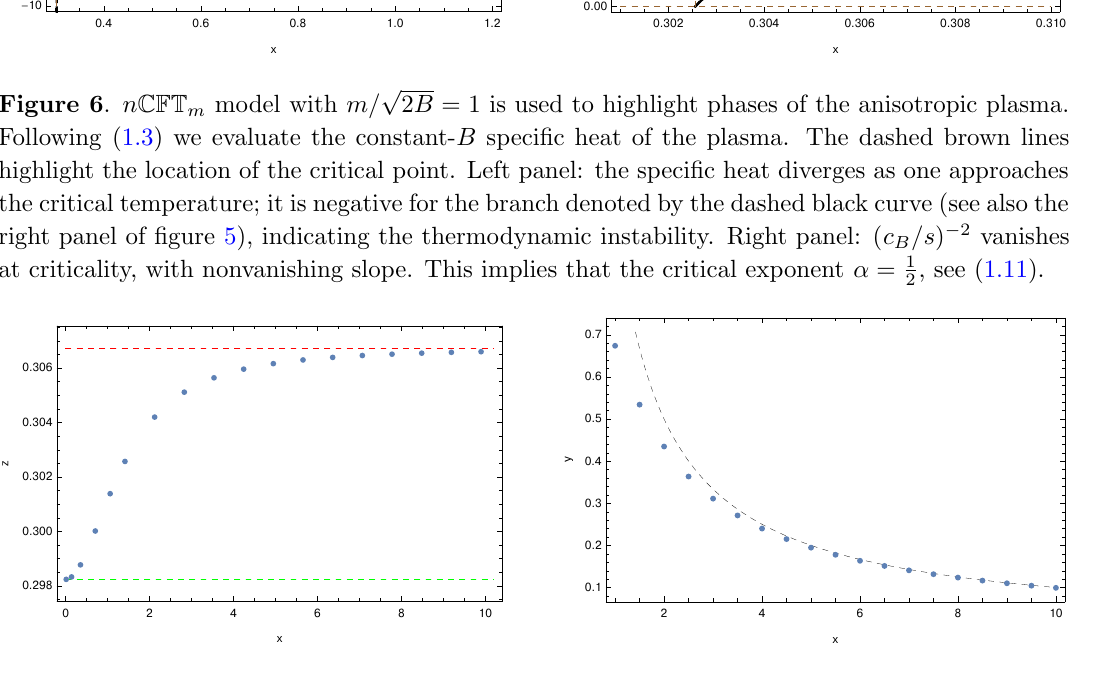
Figure 7 . n CFT m models as well as the conformal models CFT PW ;m =0 and CFT PW ;m = 1 have terminal critical temperature, separating thermodynamically stable and unstable phases. In the p p left panel we present T crit = B as function of m= 2 B ; in the right panel we present the relative entropy at criticality (cid:13) = s crit =s UV (1.13). The dots represent results for the n CFT m models; the dashed horizontal lines (left panel) represent the critical temperature for the CFT PW ;m =0 model (green) and the CFT PW ;m = 1 model (red). The dashed black curve (right panel) represents the p asymptote of (cid:13) as m= B ! 1 , see